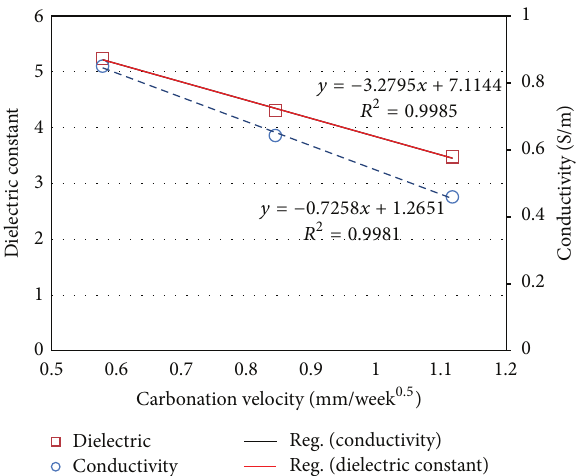
Figure 10: Relationship between carbonation velocity and EM properties.